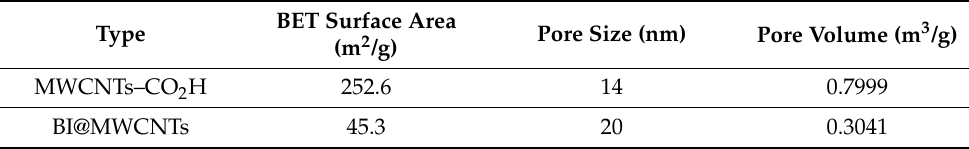
Table 1. Surface area of MWCNTs–CO 2 H and